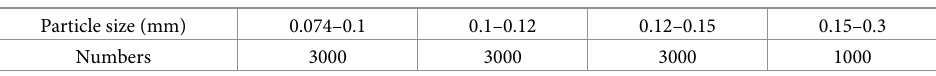
Table 4. The second type of particle grading.